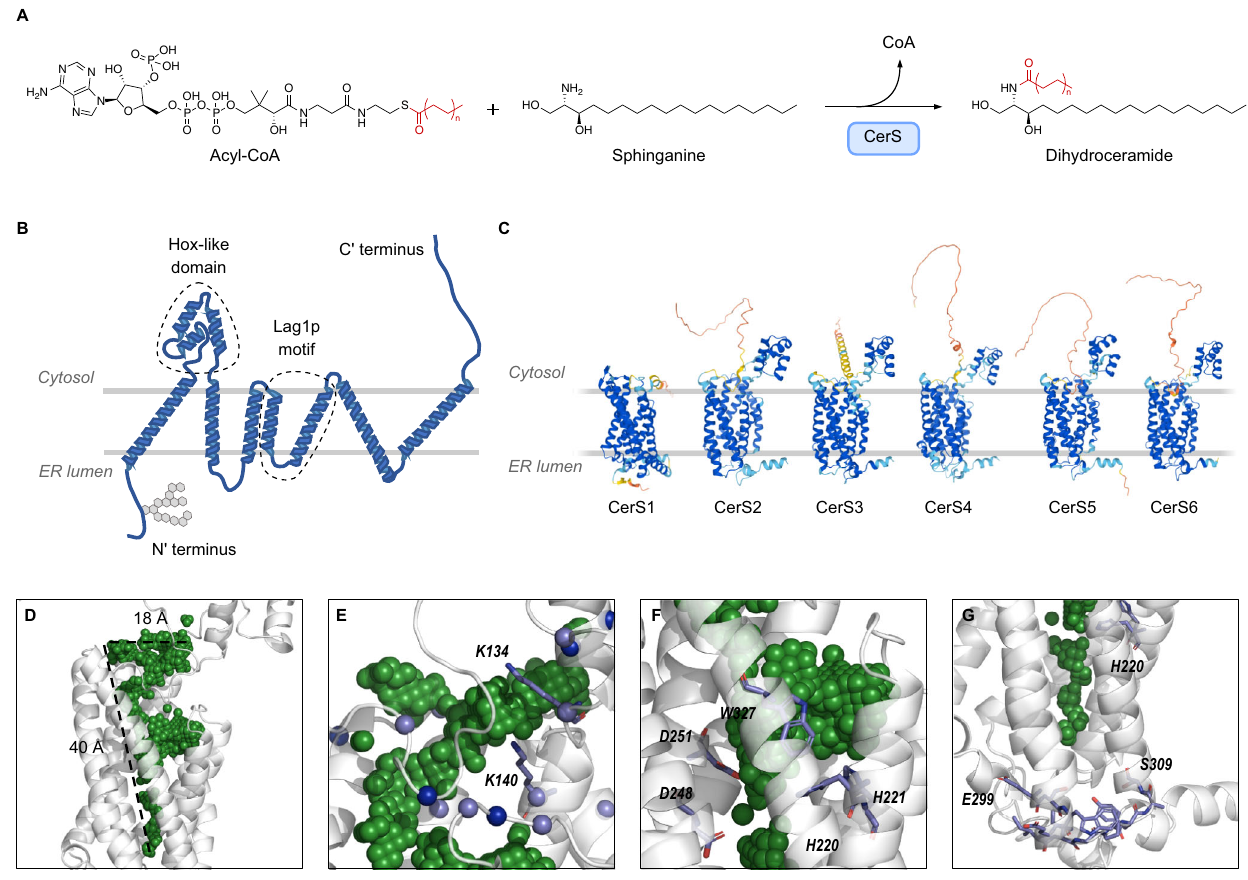
Fig. 1 | AlphaFold2 predictions of the structure of the six mammalian CerS. A Reaction scheme for CerS activity in the ceramide de novo synthesis pathway. B Putative topology of the CerS based on AlphaFold2 predictions. The Hox-like, Lag1p domain, and the N-terminal glycosylation site are indicated. C AlphaFold2 models of human CerS1-6. Note that CerS1 lacks a Hox-like domain. Models are colored by structure prediction con fi dence as estimated by predicted Local Dis- tanceDifferenceTest(pLDDT)(darkblue,pLDDT>90;lightblue,pLDDTof90 – 70; yellow, pLDDT of 70 – 50; orange, <50. D – G CerS5AlphaFold2 predicted structures showingcavitiesintheTMD.Proteiningray,cavityvolumeingreenspheres. D The